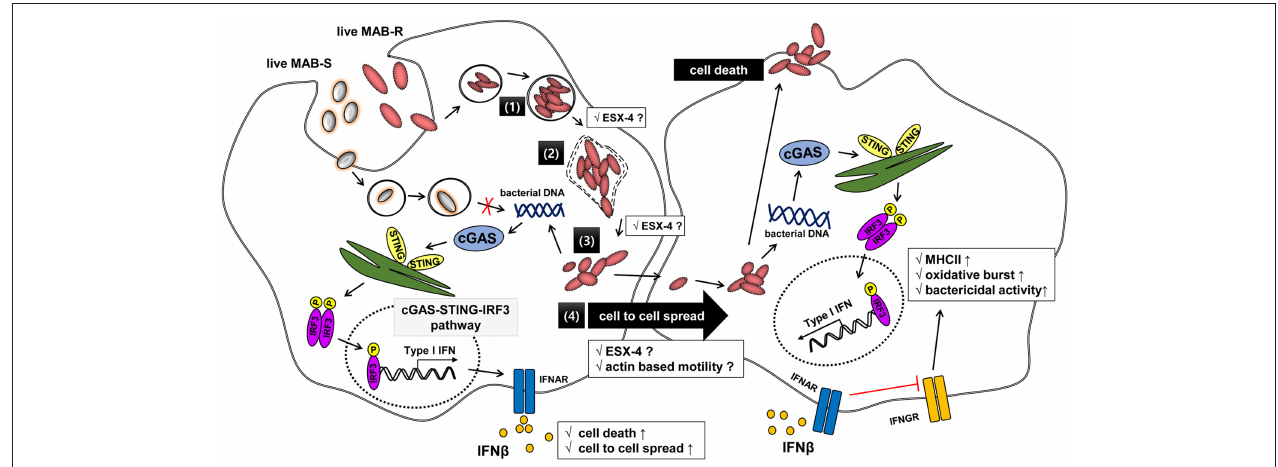
FIGURE 8 | Schematic representation showing phagosomal rupture-mediated phagosomal escape of MAB-R in infected murine macrophage, leading to Type I INF production via the cGAS-STING-IRF3 axis . Live M. abscessus (MAB-R and -S) move into macrophage cells by phagocytosis. However, different life styles within macrophages were found between MAB-R and MAB-S strains. MAB-S strains remain silent in the phagosome and cannot lead to phagosomal rupture mediated escape to cytosol. So, MAB-S strains also cannot activate Type 1 IFN production via the cGAS-STING-IRF3 pathway. However, MAB-R can replicate in the phagosome (1) and cause phagosomal rupture (2). MAB-R can escape to the cytosol (3), which produce Type I IFN (IFN β ) via the cGAS-STING-IRF3 pathway (4). Furthermore, MAB-R can move to adjacent cells by Type I IFN receptor-dependent cell-to-cell spreading. ESX-4 locus, which has been recently reported to be related to phagosomal rupture (39), may contribute into replication in phagosome (1), phagosome rupture (2), and escape into cytosol of MAB-R (3). Finally, secreted IFN- β by MAB-R infections could also contribute into bacteria proliferation by interfering with IFN- γ signaling pathway (